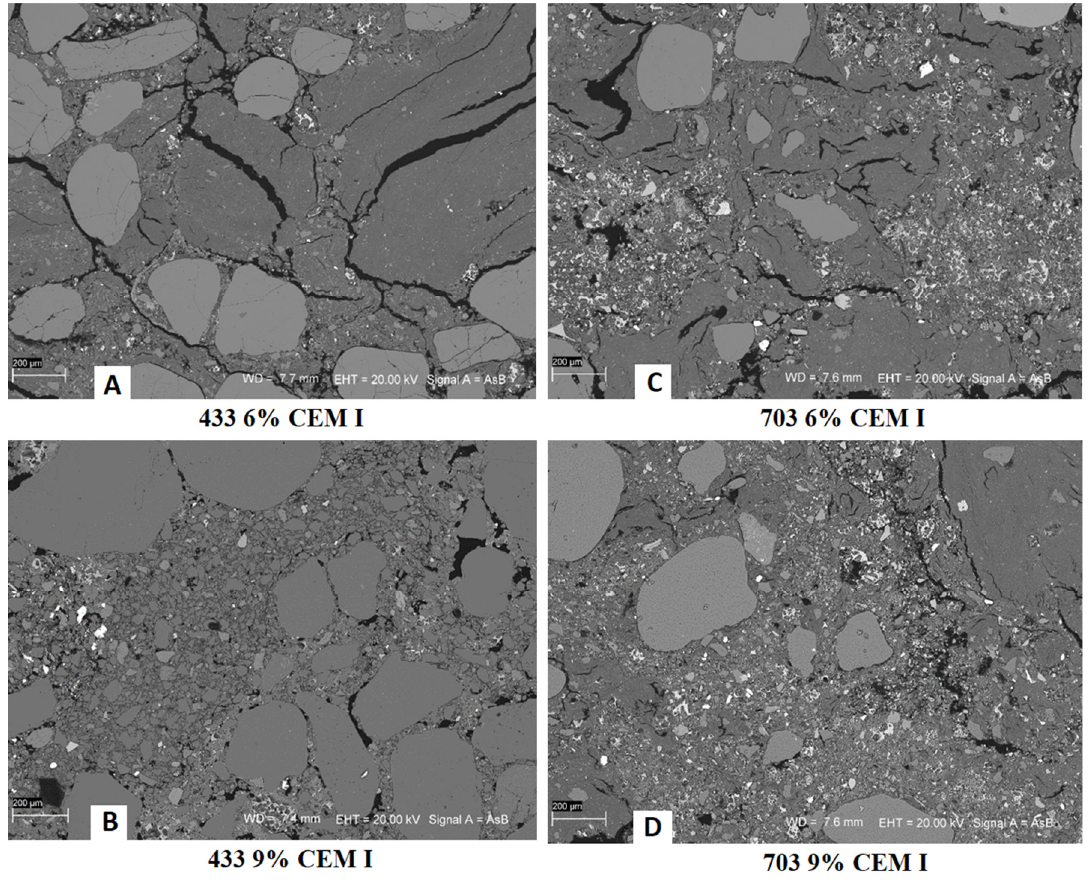
Figure 12. Scanning electron microscopy images of cement stabilized rammed earth (CSRE) samples containing 6 and 9% of Portland cement.